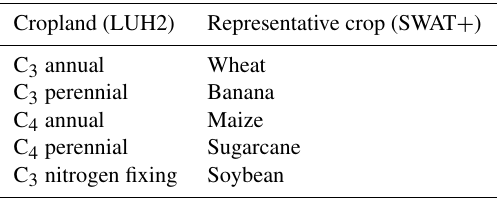
Table 2. Representative crop for LUH2 cropland used in SWAT +